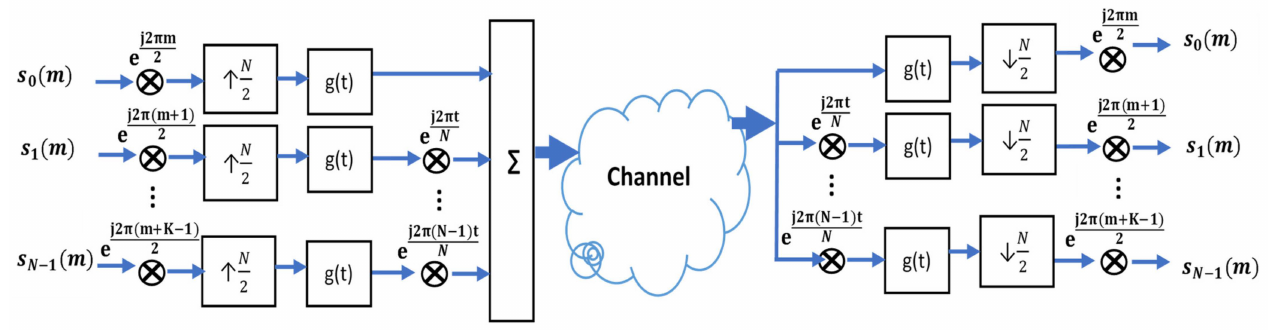
Figure 10. FBMC-OQAM transceiver.